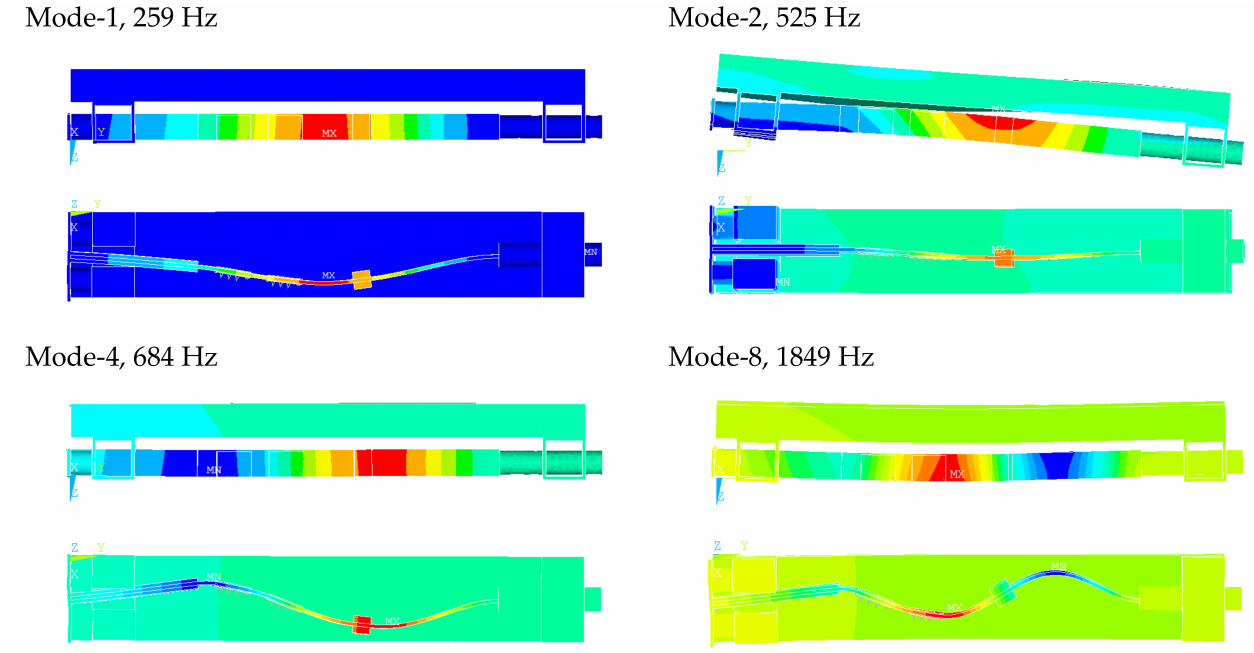
Figure 4. Natural frequencies and mode shapes of the